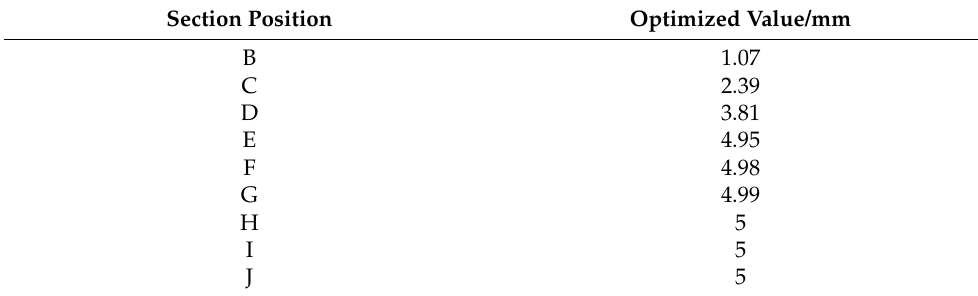
Table 3. Optimization results of the wing rail lifting value of each section.